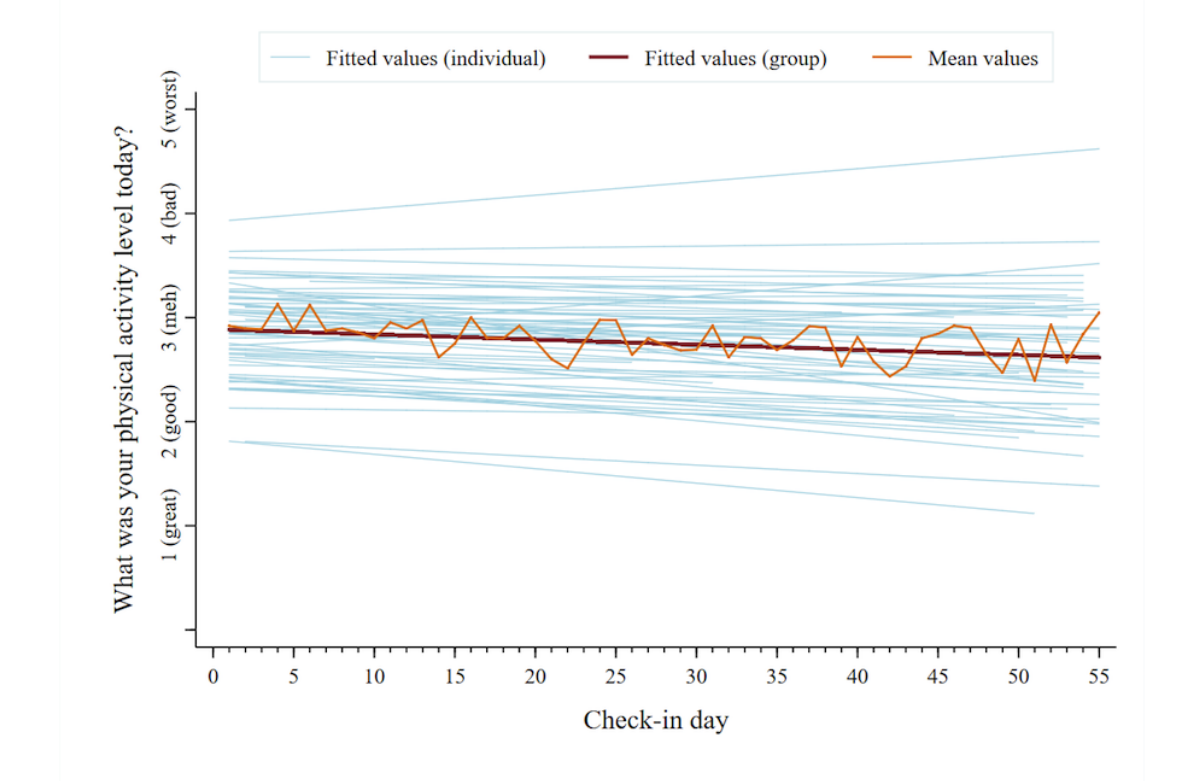
Figure 8. Self-reported physical activity across 55 days using the iCanCope daily